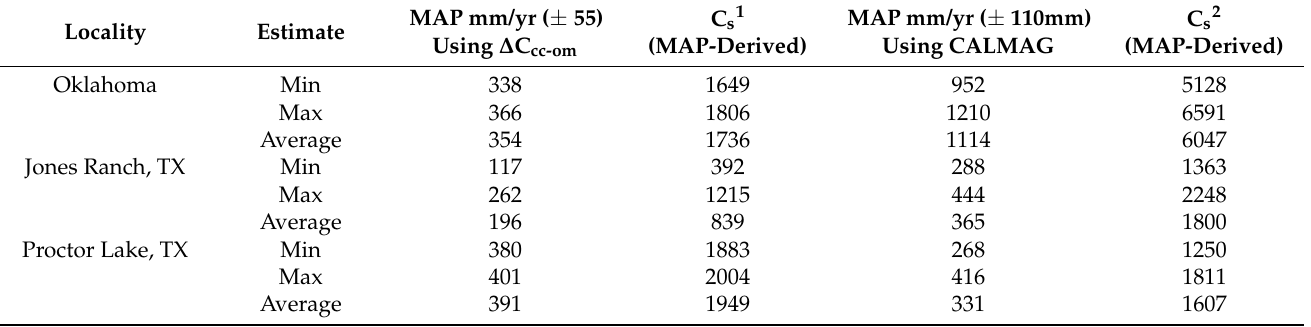
Table 2. The mean annual precipitation estimates of Lower Cretaceous localities in Texas and Oklahoma using ∆ 13 C cc-om [42], which are newly presented here, and CALMAG weathering index [41] MAP estimates, as reported in Andrzejewski and Tabor [16]. Soil-respired p CO 2 was then estimated from the mean annual precipitation estimates using the equations derived by Cotton and Sheldon (Equation (3), [40]). C s1 calculated soil-respired p CO 2 using MAP de- rived from ∆ 13 C cc-om . C s2 calculated soil-respired p CO 2 using MAP derived from the CALMAG weathering